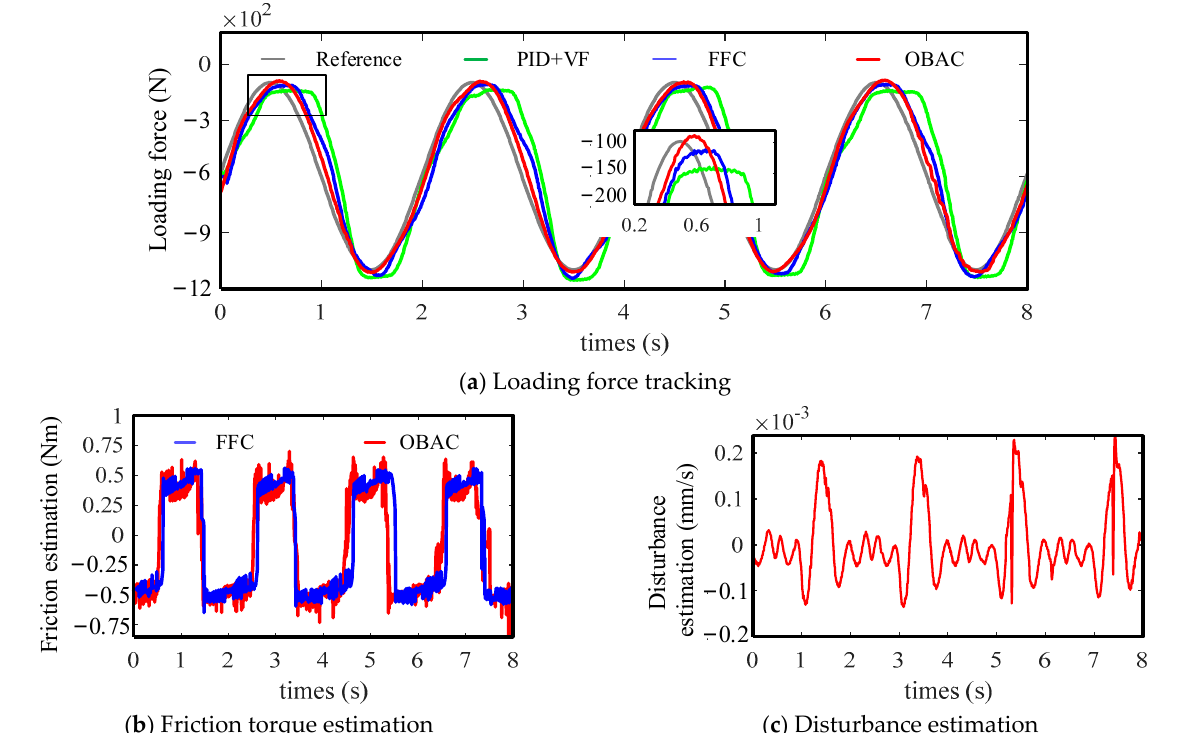
Figure 5. Static loading experiment results with different control methods. Table 2. Performance indexes at static loading experiment.